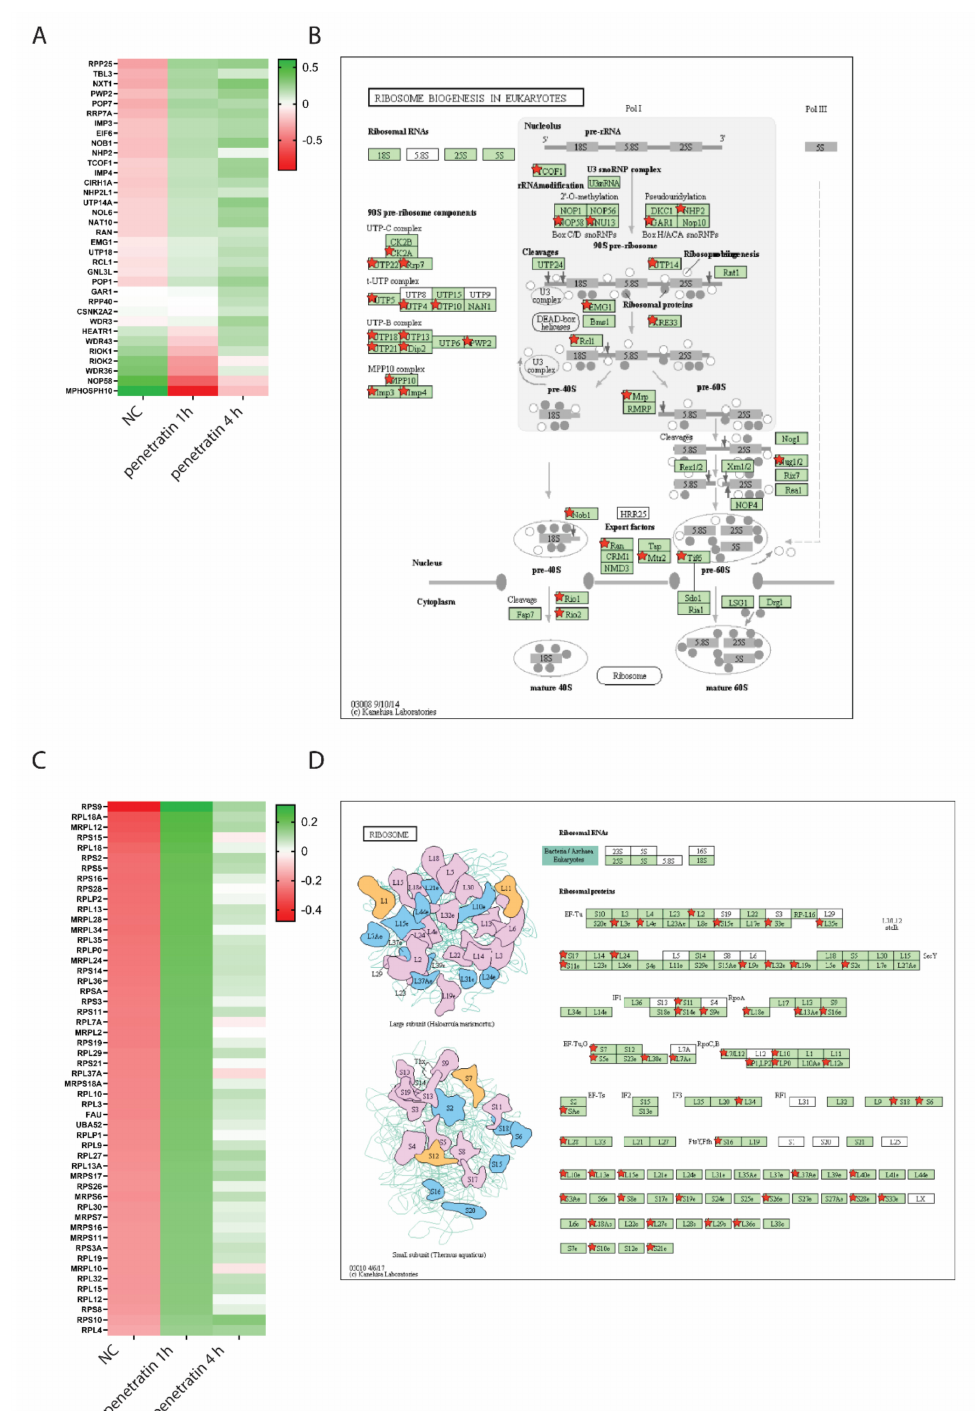
Figure 5. ( A ) Heatmap of di ff erentially expressed genes related to GO-term “Ribosome biogenesis in Eukaryots”. Genes are organized in descending order based on the averaged log2(normalized read counts) for each sample. ( B ) KEGG-pathway map of genes related to “Ribosome biogenesis in Eukaryotes”. Genes marked with star are di ff erentially expressed in penetratin treated samples. ( C ) Heatmap of di ff erentially expressed genes related to GO-term “Ribosome”. Genes are organized in descending order based on the averaged log2(normalized read counts) for each sample. ( D ) KEGG-pathway map of genes related to “Ribosome”. Genes marked with star are di ff erentially expressed in penetratin-treated